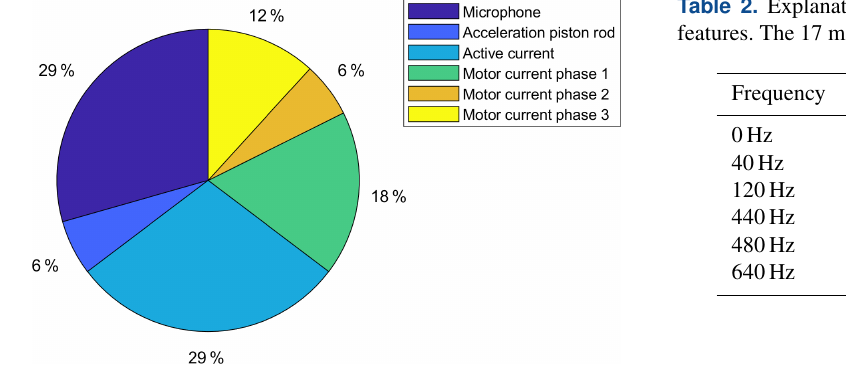
Figure 7. The 17 most important features by sensors, selected with RFESVM. Only 6 of the 11 sensors contribute to the 17 most im- portant features.